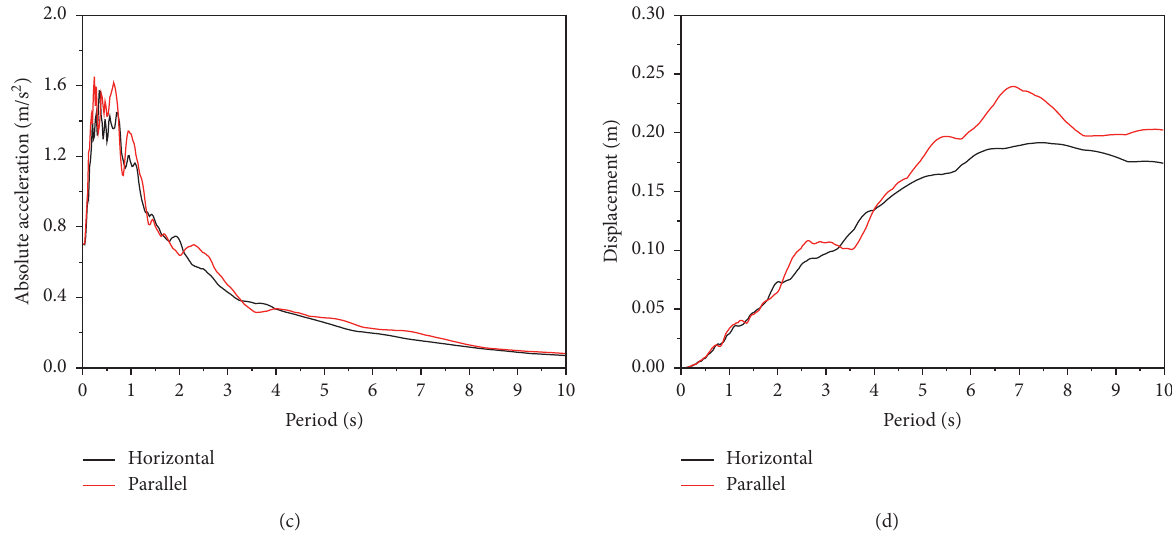
Figure 17: (a) Acceleration spectra of horizontal component without amplitude modulation; (b) displacement spectra of horizontal component without amplitude modulation; (c) acceleration spectra of parallel component with amplitude modulation; (d) displacement spectra of parallel component with amplitude modulation.